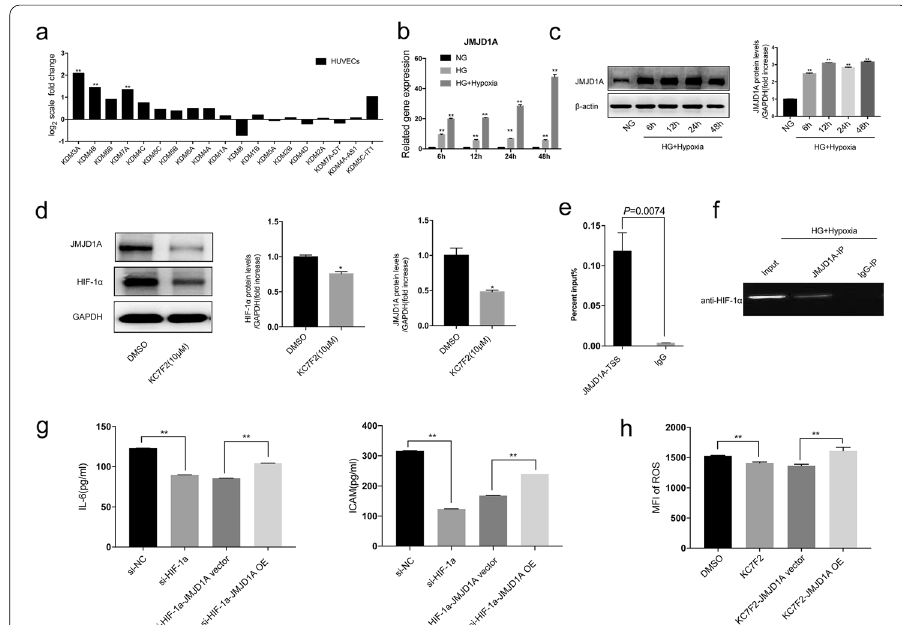
Fig. 7 Inhibition of HIF-1α decreases inflammation and oxidative stress in HUVECs via JMJD1A induced by high glucose and hypoxia. a Quantitative gene expression changes of JMJD families under high glucose and hypoxia. Cells were treated with high glucose and hypoxia for 6, 12, 24, and 48 h, qRT-PCR ( b ) and western blotting ( c ) showing the expression of JMJD1A. d Cells were treated with or without KC7F2 (10 µM) before exposure to high glucose and hypoxia for 48 h. The total proteins of HIF-1α and JMJD1A were collected and analyzed using western blotting as described under Materials and Methods. The relative densities of HIF-1α and JMJD1A were calculated according to GAPDH. e Cells were treated with high glucose and hypoxia for 24 h. ChIP assay showing HIF-1α bound to the JMJD1A promoter in vitro . The promoter regions of JMJD1A (–2.5 kb to –500 bp) were amplified using the input and immunoprecipitated DNA as templates. g Cells were treated with si-HIF-1α/KC7F2 and JMJD1A overexpression induced by high glucose and hypoxia for 48 h. ELISA and flow cytometry showing the secretion of ( g ) IL-6, ICAM-1, and h ROS. n 3; * p < 0.05 and **p < 0.01 = vs. DMSO. DMSO-treated cells, DMSO; HIF-1α inhibitors KC7F2 (10 µM)-treated cells, KC7F2 (10 µM); HG, high glucose; HG Hypoxia, combined stimulus with high glucose and hypoxia; NG, +